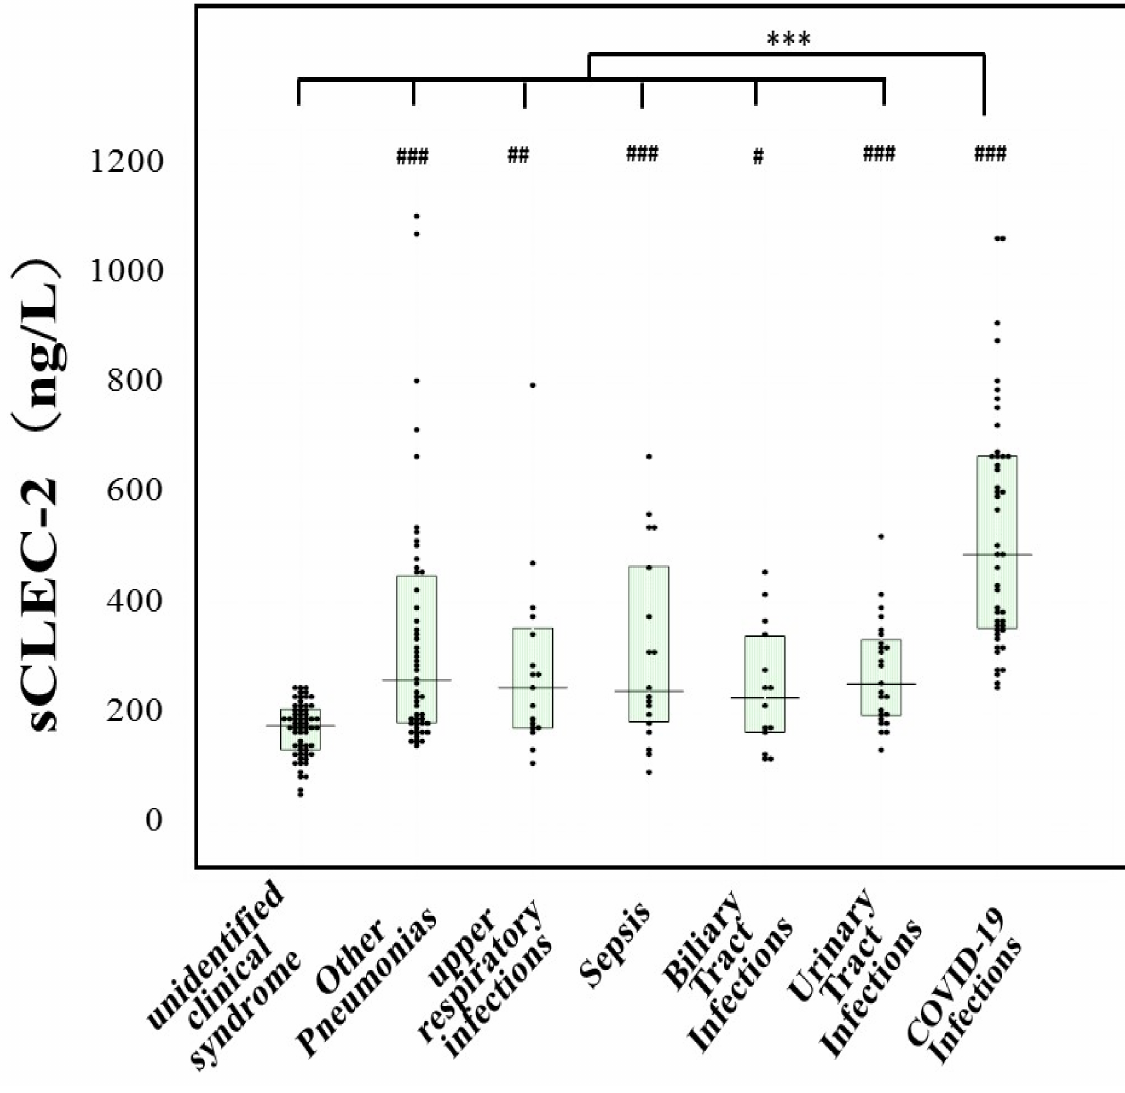
Figure 2. Plasma levels of sCLEC-2 in various infections and COVID-19 infection ***, p < 0.001 in comparison with COVID-19 infection; # , p < 0.05 in comparison with unidentified clinical syndrome; ## , p < 0.01 in comparison with unidentified clinical syndrome; ### , p < 0.001 in comparison with unidentified clinical